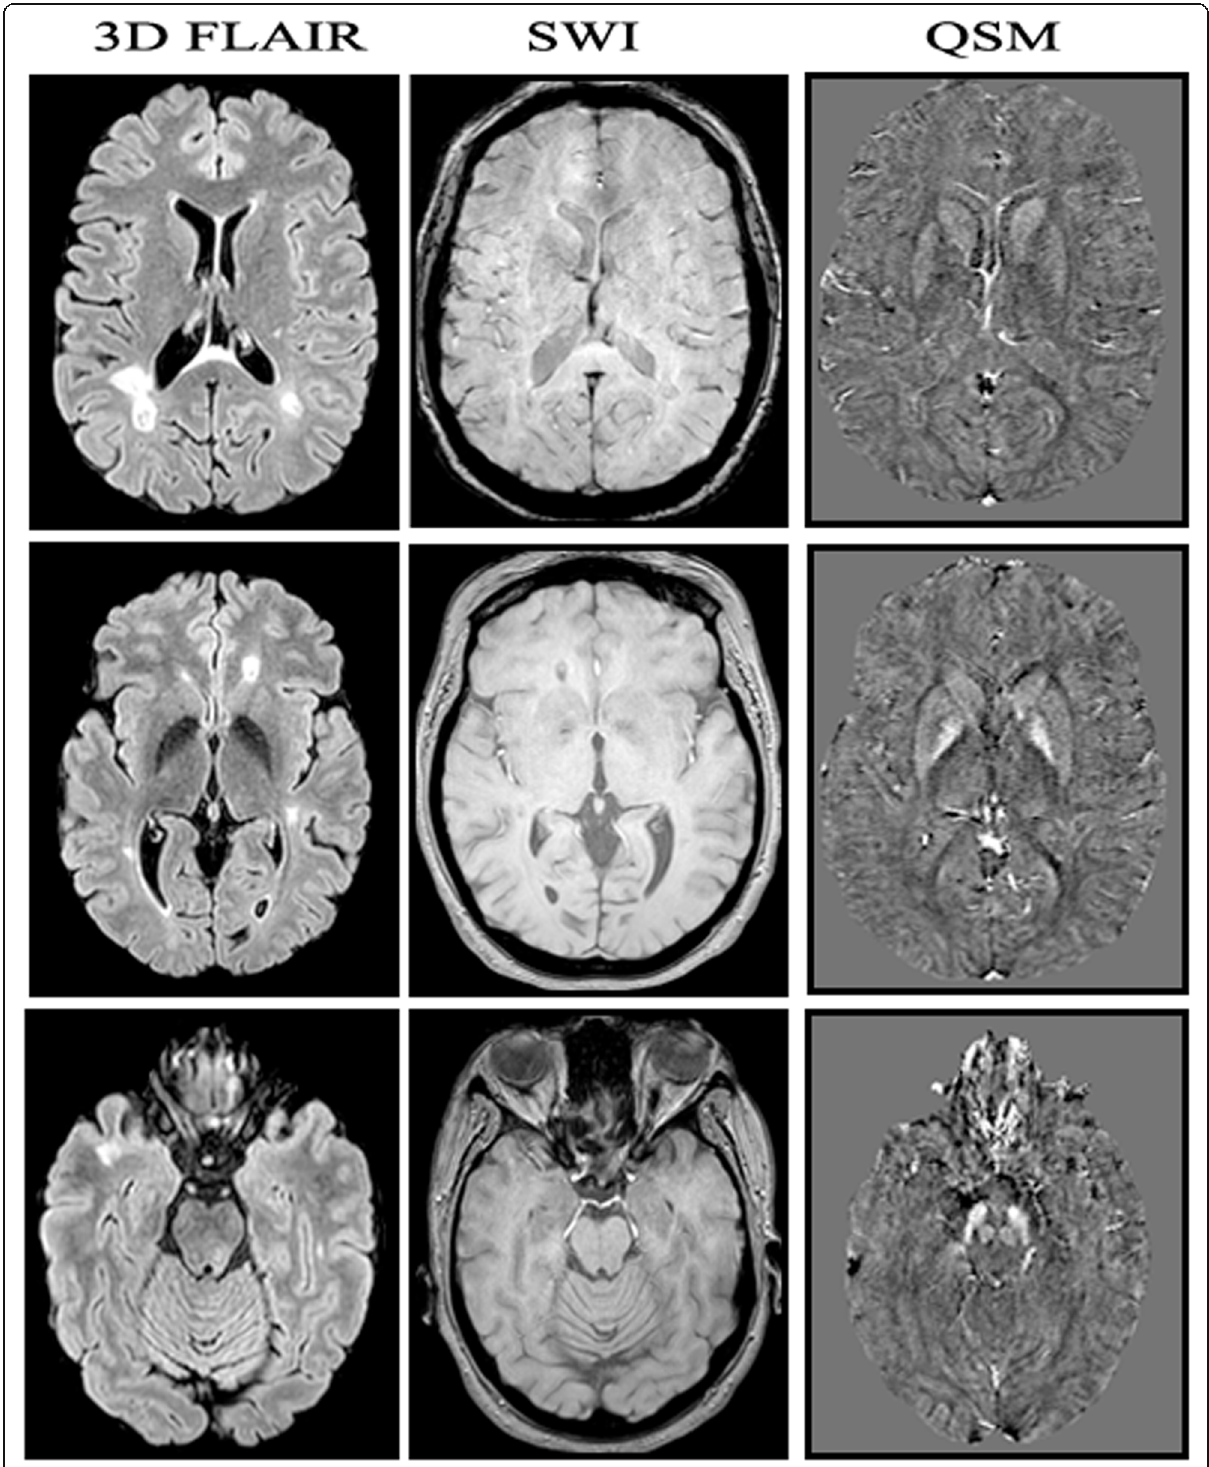
Fig. 1 Magnetic resonance image of the brain of a 36-year-old lady diagnosed with relapsing-remitting multiple sclerosis. Three different imaging series of corresponding axial cuts are demonstrated, i.e ., three-dimensional fluid-attenuation inversion recovery images, susceptibility-weighted images, and the reconstructed quantitative susceptibility